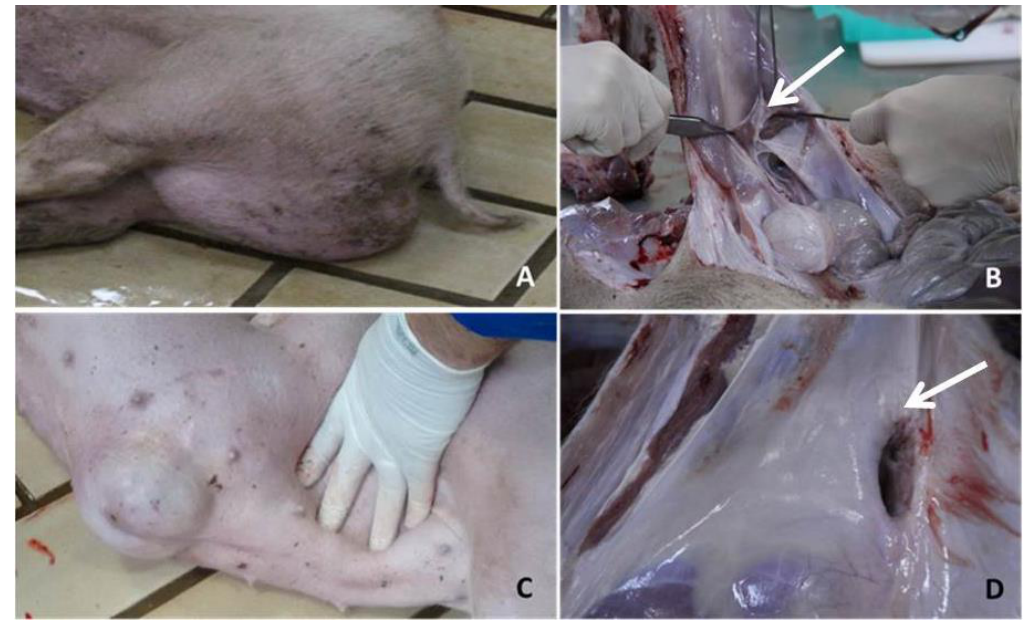
Figure 1. Pathological analysis. Legend: ( A ) swine affected with scrotal hernia. ( B ) Region affected with scrotal hernia (the white arrow shows the inguinal ring). ( C ) Swine affected with umbilical hernia. ( D ) Region affected with umbilical hernia (the white arrow shows the umbilical